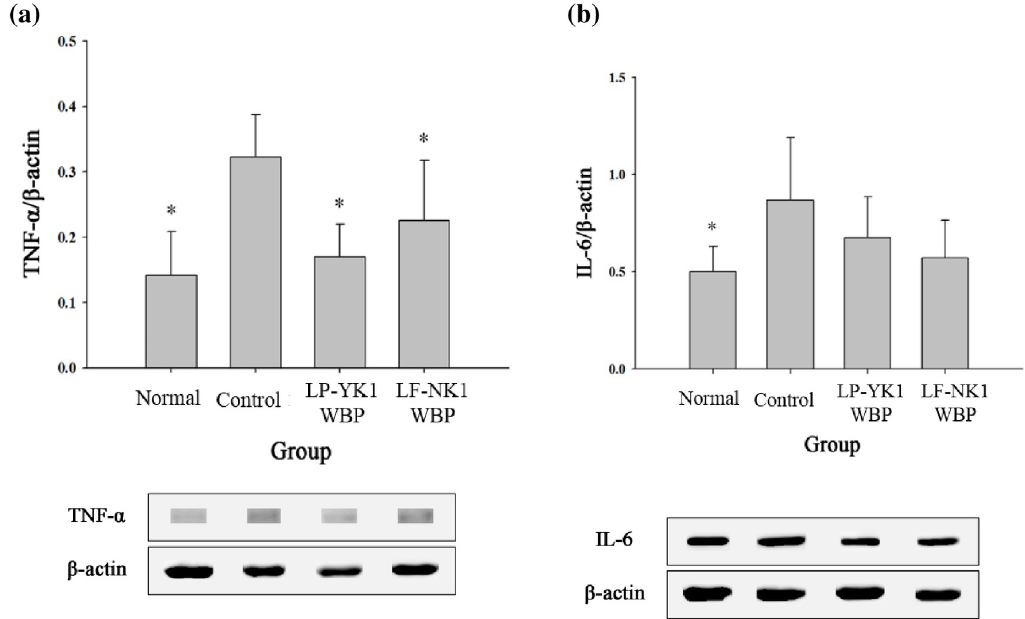
Fig 3. Analysis of protein levels of inflammatory cytokines in gingival tissue after treatment with fermented whey bioconversion products (WBPs) for 8 weeks. (a) TNF- α (b) IL-6. Normal: Administration of phosphate buffered saline (PBS) without inducing periodontitis, Control: Administration of PBS after inducing periodontitis, LP-YK1 WBP: Administration of WBPs by L . plantarum SMFM2017-YK1 after inducing periodontitis, LF-NK1 WBP: Administration of WBPs by L . fermentum SMFM2017-NK1 after inducing periodontitis. � Statistically significant, compared to control group by pairwise Student’s t -test ( p < 0.05).